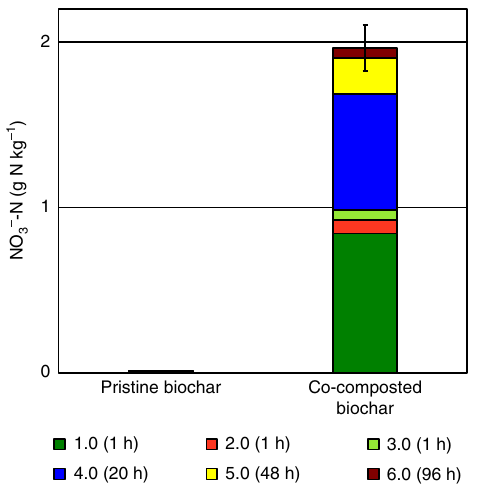
Fig. 1 Biochar nitrate content based on repeated extractions with 2 M KCl. Each segment of the stacked bar represents one step of six consecutive extractions with KCl: the fi rst, second and third extraction took 1 h each, the fourth took 20 h, the fi fth 48 h, and the sixth took 95 h. Error bar represents 1 S.E. of the total extraction carried out in